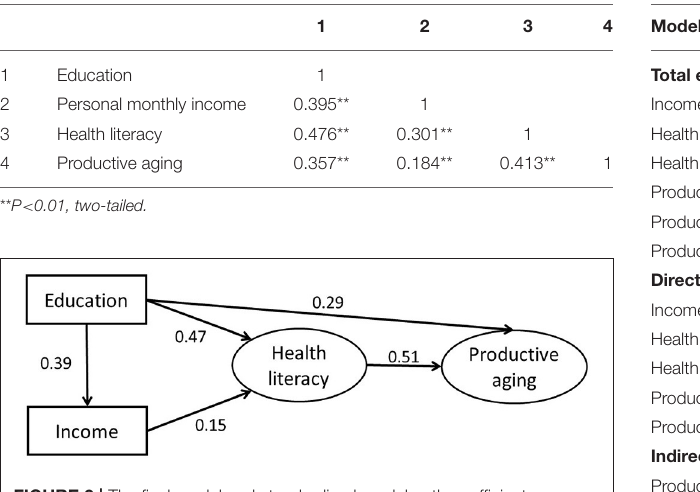
FIGURE 2 | The final model and standardized model path coefficient.